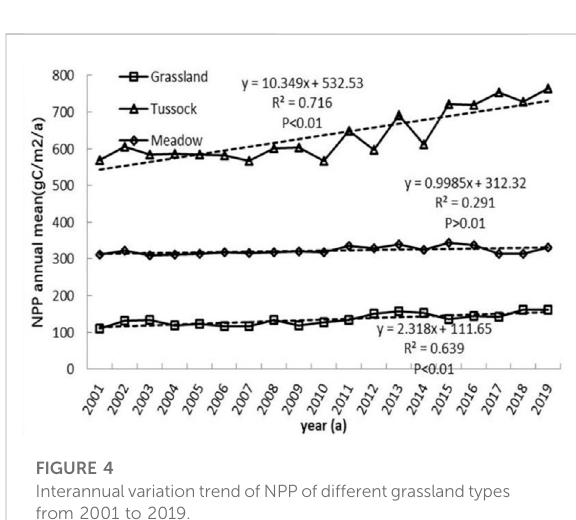
FIGURE 4 InterannualvariationtrendofNPPofdifferentgrasslandtypes from 2001 to 2019.